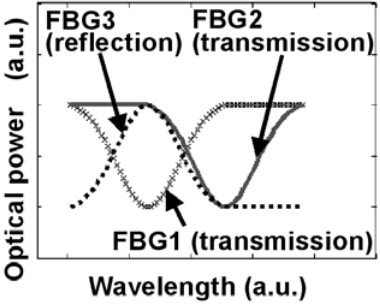
Figure 2. Optical spectra of three FBGs (FBG1&FBG2: reference FBGs; FBG3: sensing FBG).